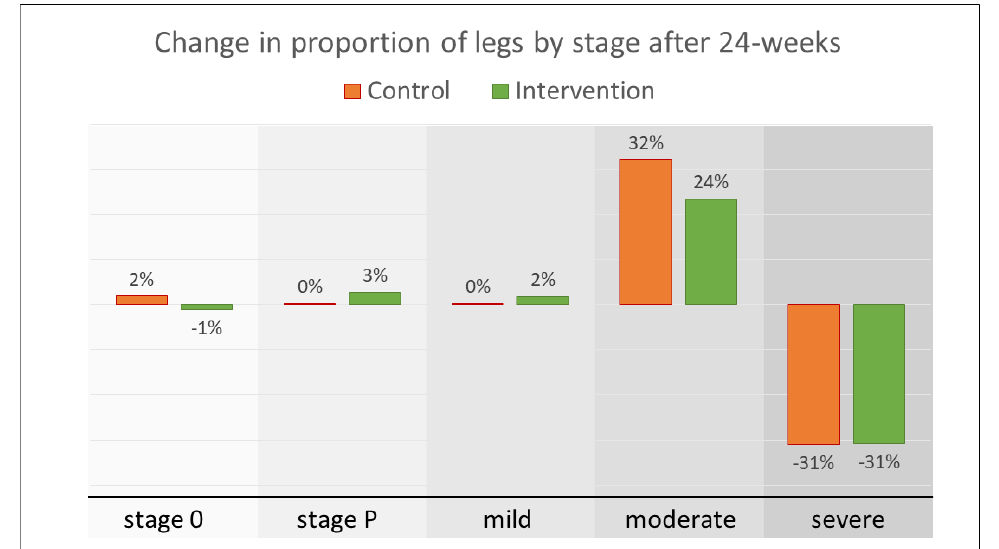
Figure 3 . Change in proportion of legs by group and stage. Figure 3. Change in proportion of legs by group and